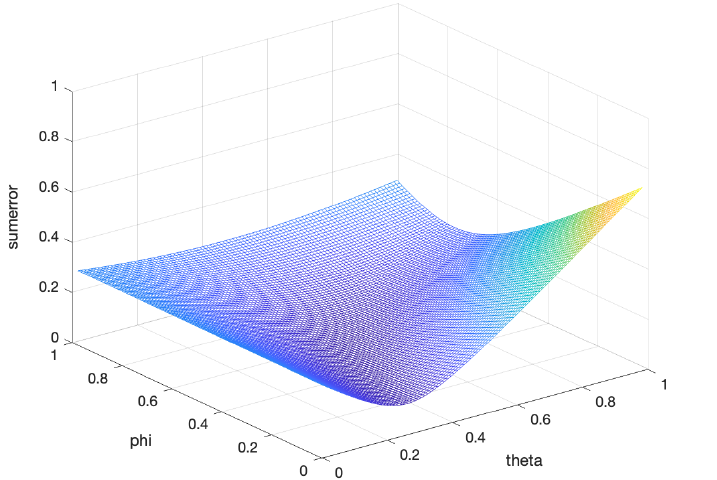
Figure 2. Thesum of the error of the five-fold cross-validation between the proposed estimation and the population covariance matrix under the different θ and φ for N = 200.